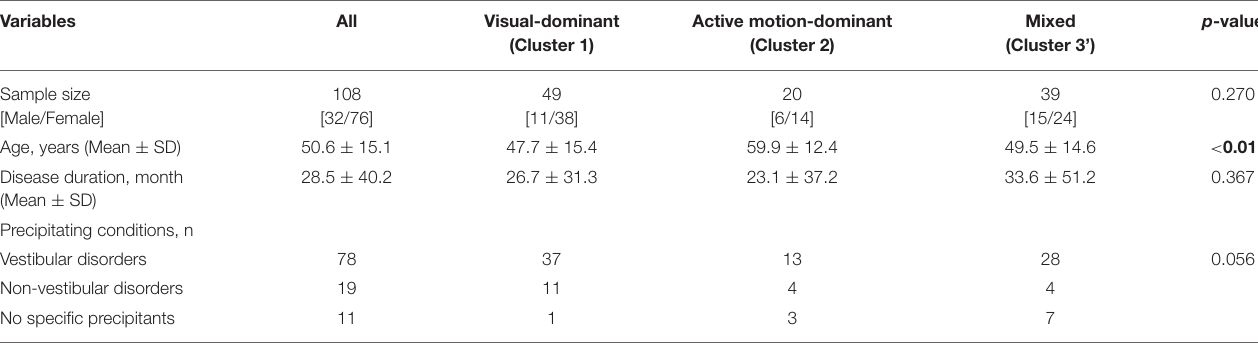
TABLE 4 | Basic demographic characteristics of the three